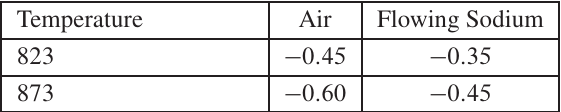
Table 4. Slope of strain – life plots at different tempera- tures for 316L(N) base material.